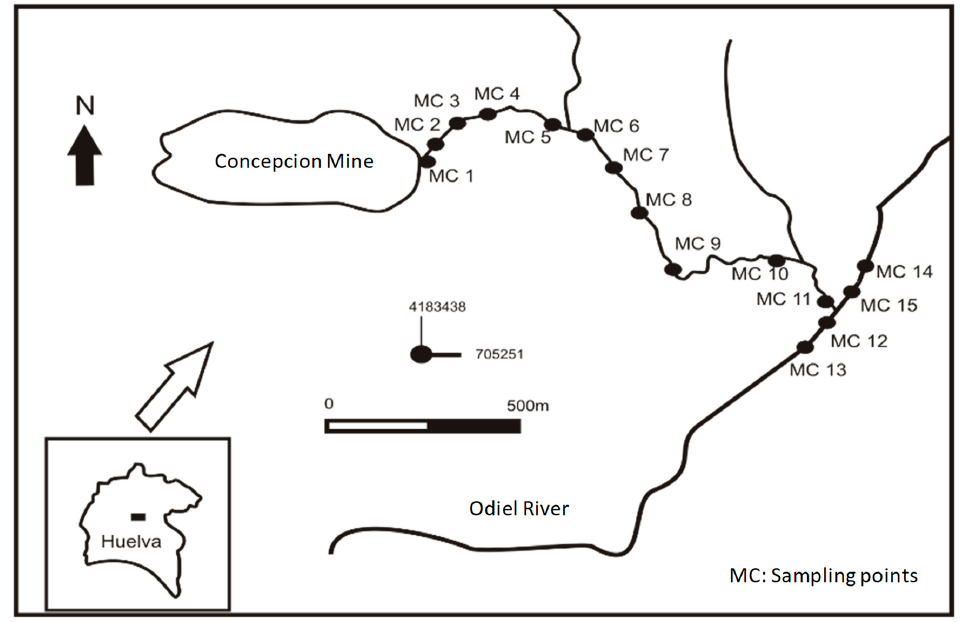
Figure 2. Location map of the sampling points.